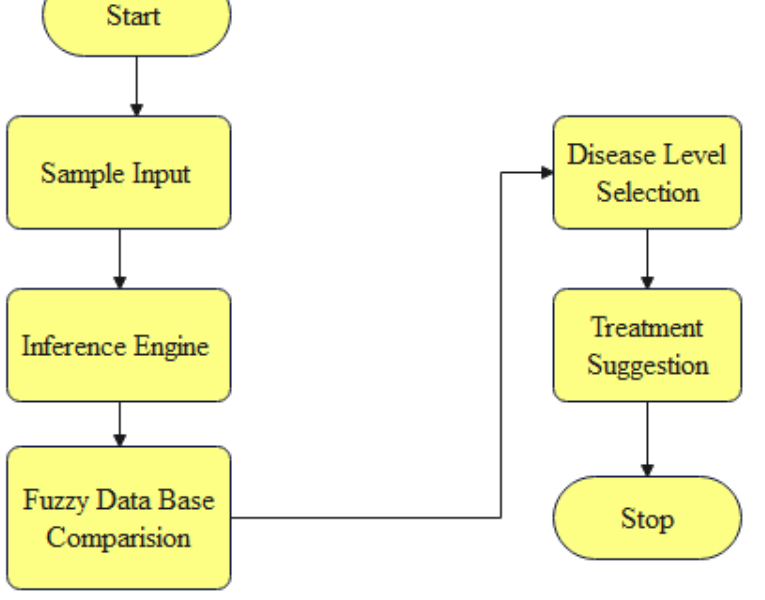
Figure 1. The system flow diagram.